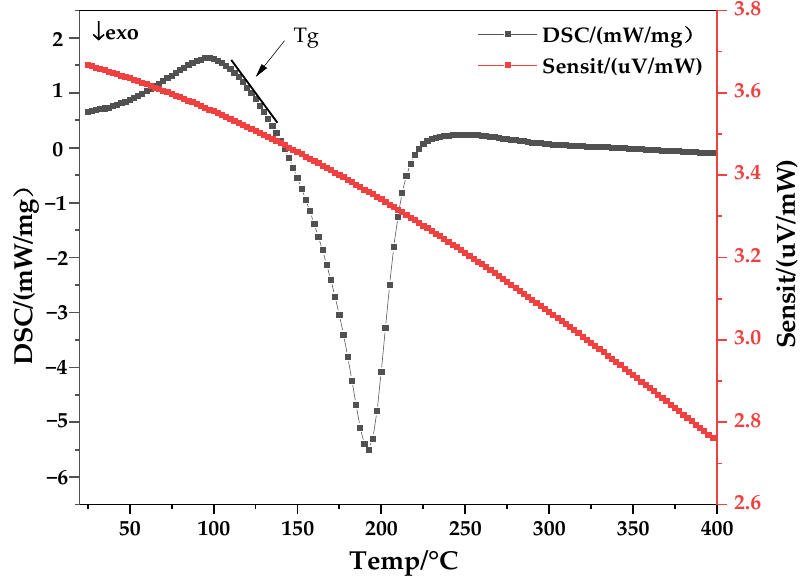
Figure 3. Thermogravimetric scanning calorimetry and differential thermal curves of GO. Thirdly, Figure 4 shows the FTIR spectrum of GO nanoparticles. The absorption peaks on the spectrum are –OH stretching (3417.09 cm − 1 ), C=O stretching in the carboxylic acid (1730.31 cm − 1 ), C=C stretching (1585.62 cm − 1 ), C–OH stretching (1188.11 cm − 1 ), and C–O stretching (1049.68 cm − 1 ), respectively, which confirms that GO contains a large number of oxygen-containing functional groups, and the presence of hydroxyl groups can form hydrogen bonds to enhance the interaction between the nanosheet and the